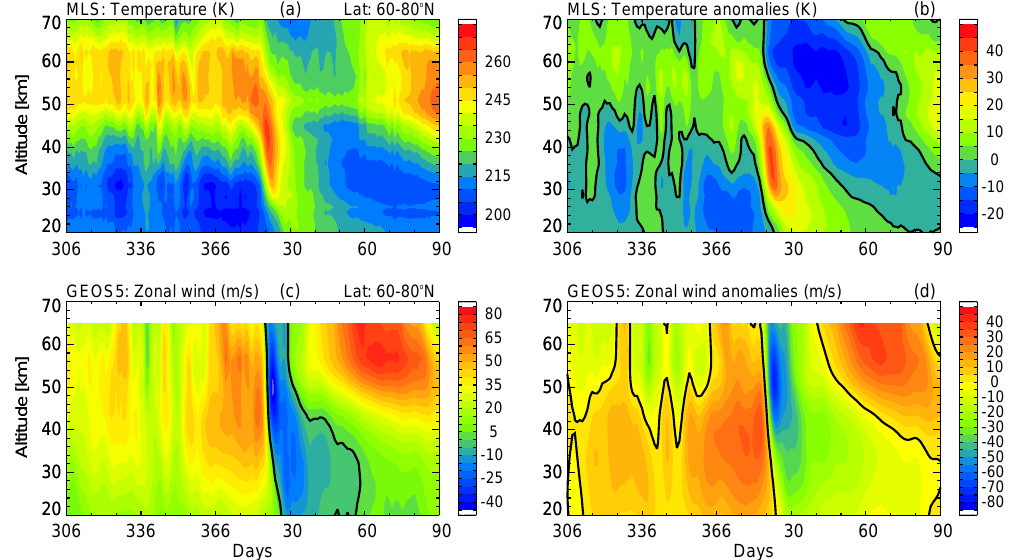
Fig. 2. Time–altitude sections of the (a) MLS temperature, (b) temperature anomalies, (c) zonal mean zonal wind from MERRA reanalysis, and (d) zonal wind anomalies centered over latitude range 60–80 ◦ N during November 2008 to March 2009. A thick solid black line represents the zero